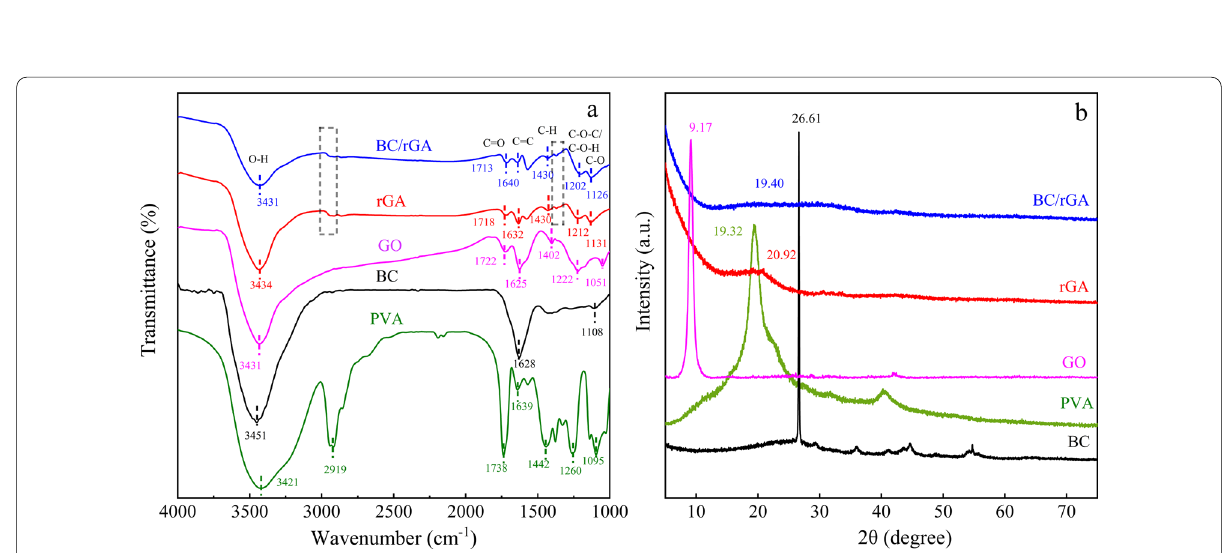
Fig. 2 The FTIR spectra ( a ) and XRD patterns ( b ) of different